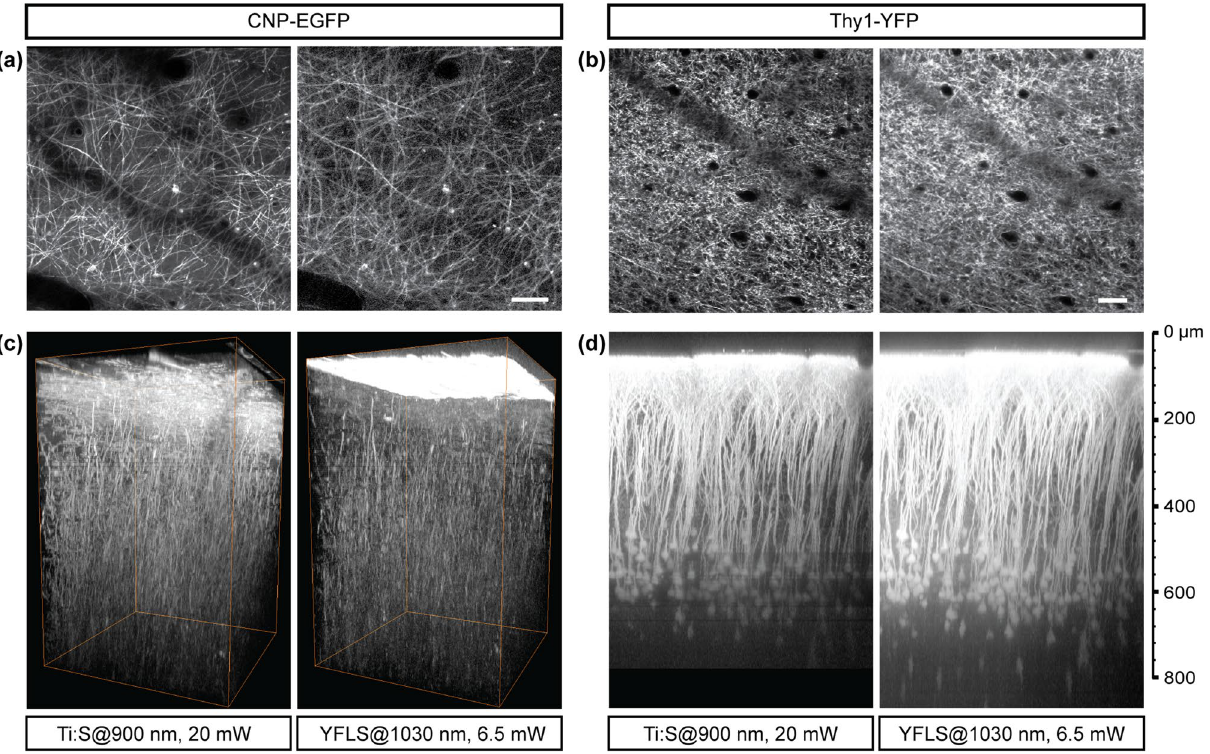
Figure 2. Intravital imaging of transgenic CNP-EGFP and Thy1-YFP brains by the 1030-nm YFLS vs. the 900-nm Ti:Sapphire laser. ( a , b ) The superficial cortex on the normalized intensity scales. Scale bars, 50 µm. ( c ) Volumetric rendering of a CNP-EGFP brain with a depth range of 450 µm. ( d ) Thy1-YFP, maximum intensity projection of an axial stack on a logarithmic intensity